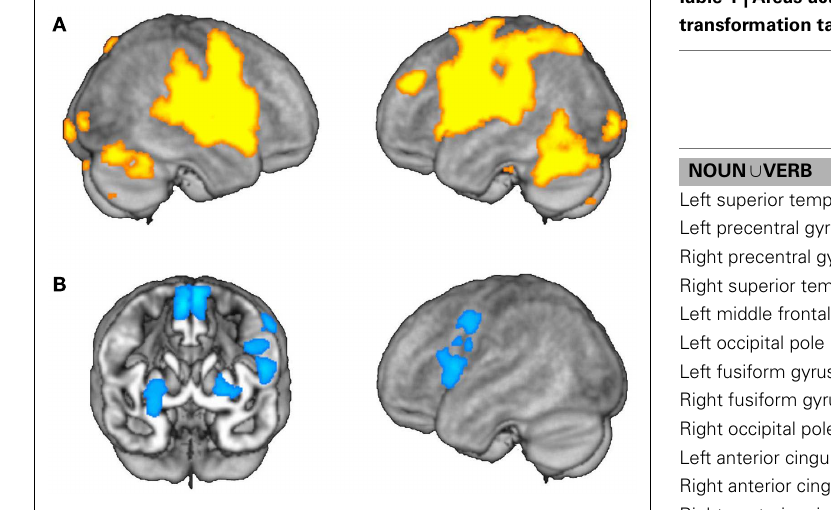
Table 1 |Areas activated for nouns and verbs in the morphological